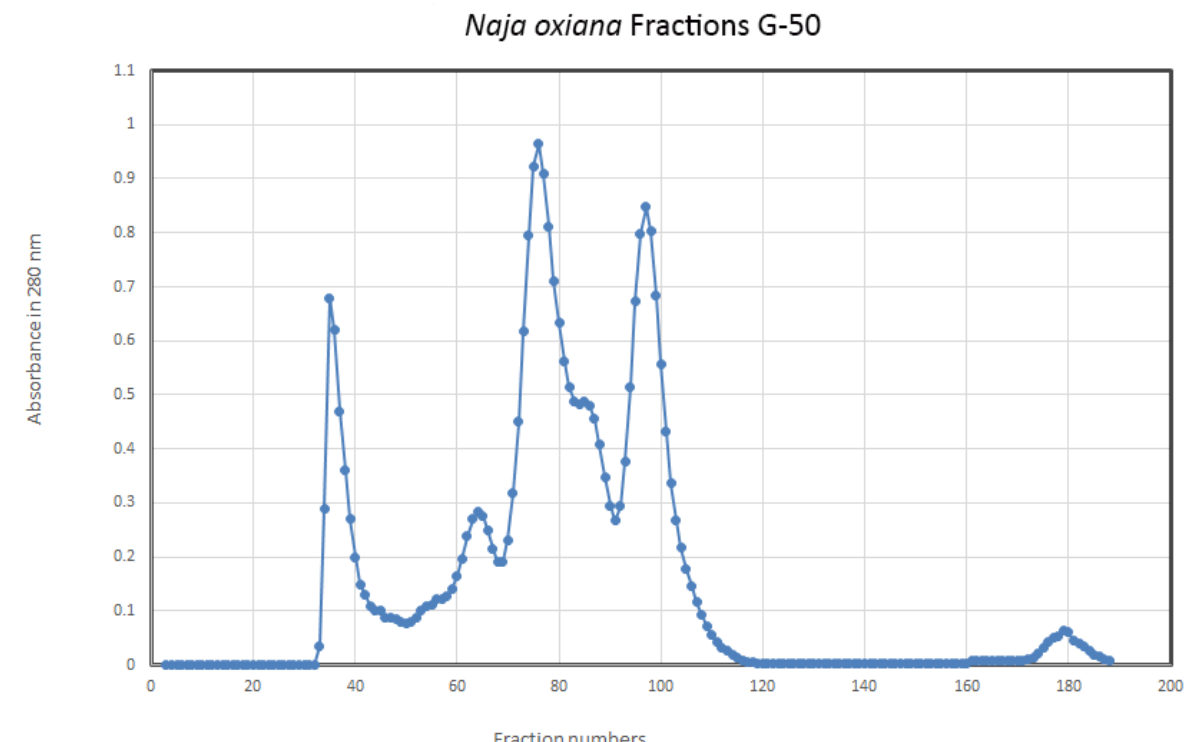
Figure 1. Gel filtration chromatography of Naja oxiana venom on Sephadex G-50. An amount of 180 mg of crude venom was separated on a 2 x 90 cm column previously equilibrated with phosphate buffer pH 7.5. Five milliliter samples were collected at a flow rate of 50 mL/h and their absorbance was measured at 280 nm. Four well-separated fractions of interest (F1, F2, F3 and F4) were taken forward for analysis.